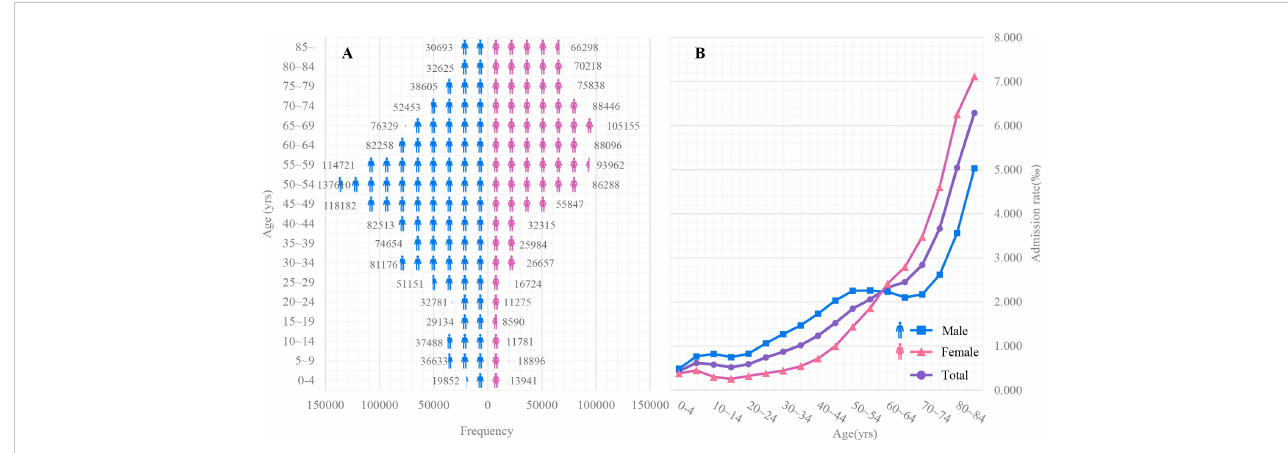
FIGURE 1 The frequency (A) and admission rate (B) for male and female inpatients with traumatic fractures among different age groups in China in